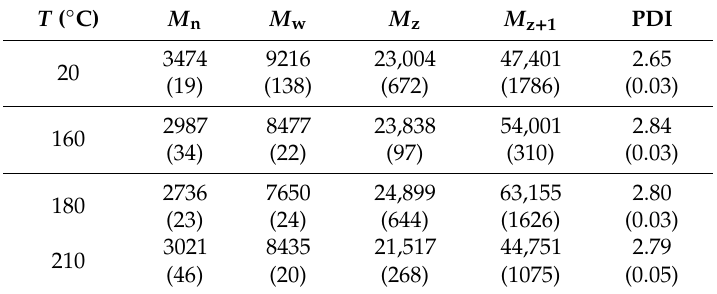
Table 1. Size exclusion chromatography (SEC) results of oak wood lignin before and after thermal treatment a,b .